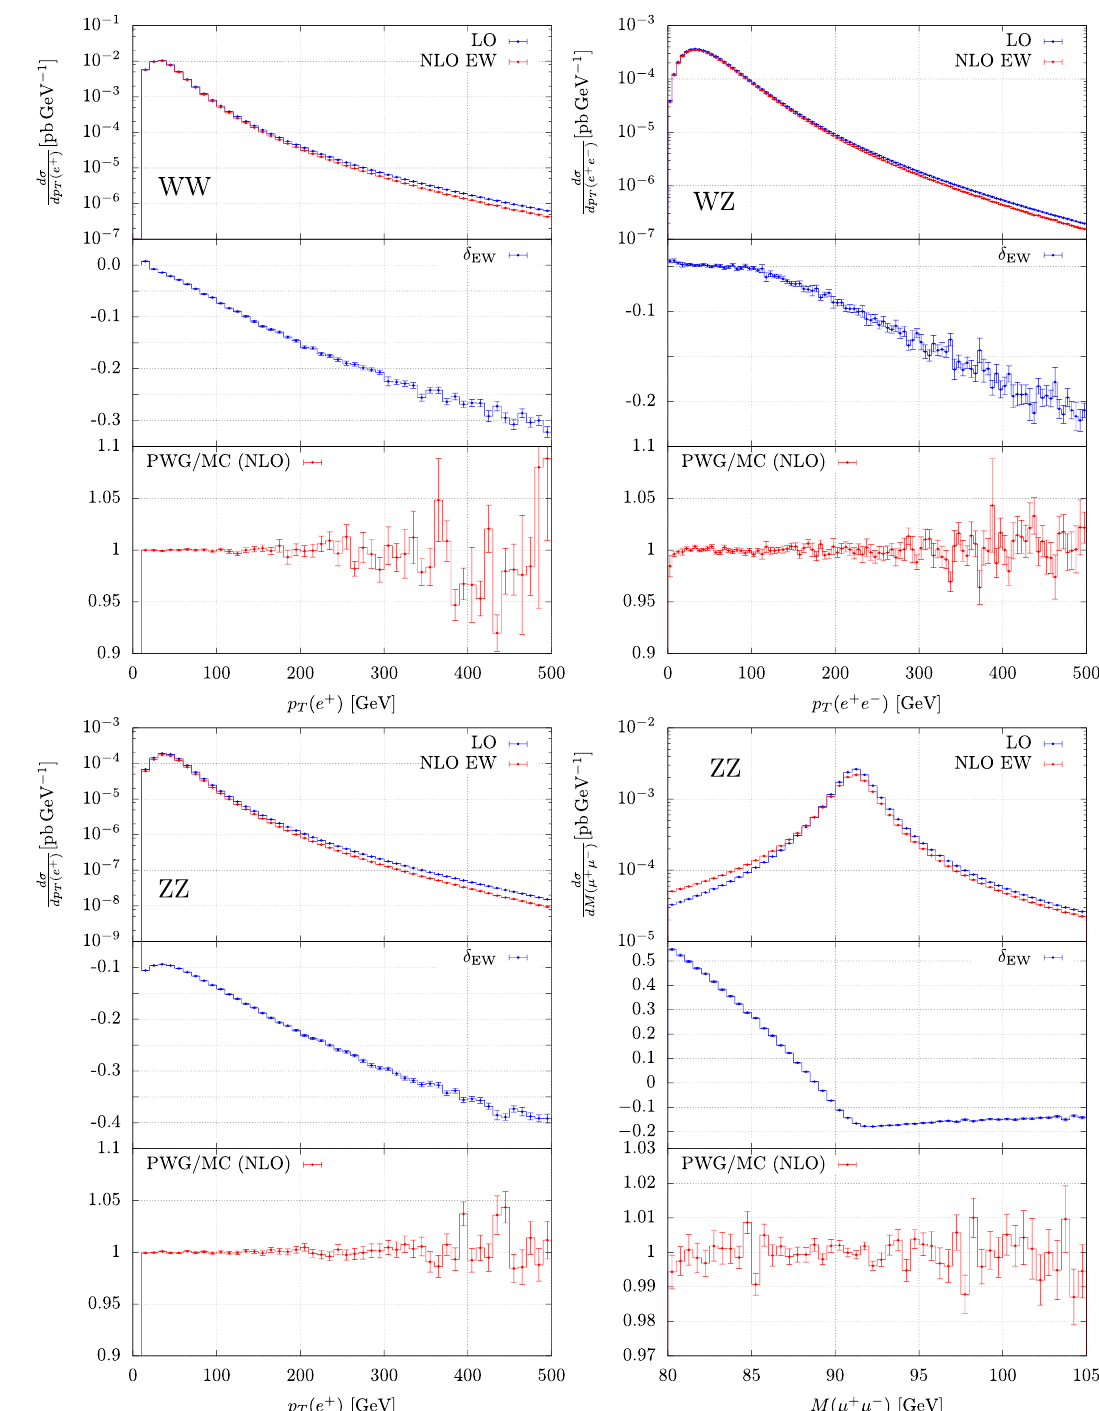
Fig. 3 NLO EW corrections to pp → e + ν e μ − ν μ (top left), pp → μ + ν μ e − e + (top right), and pp → μ + μ − e − e + (bottom) at the dif- ferential distribution level. The factorization scale is set to μ = ( M OS + M OS )/ 2 ( V , V (cid:3) = W , Z ). Top panels: differential distributions V V (cid:3)